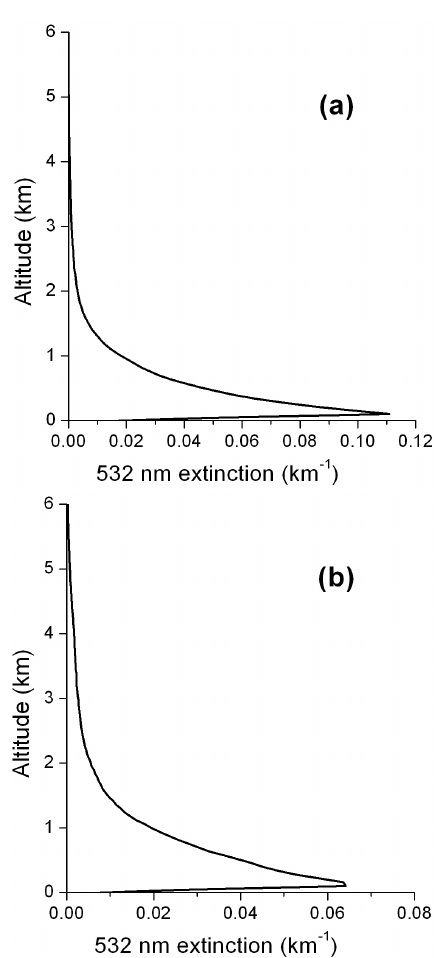
Fig. 13. Monthly-mean Arctic profiles, 61–82 ◦ N, night only.